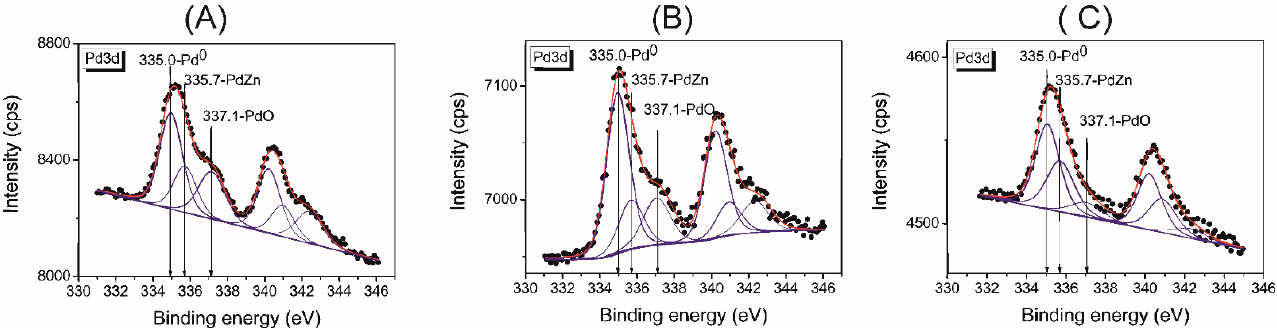
, ( B ) PdZn/Ti 0.95 Ce 0.05 O 2 and ( C ) 2 , PdZn/Ti 0.95 Ce 0.05 O 2 , and PdZn/Ti 0.8 Zn 0.2 O 1.8 after differ- 2